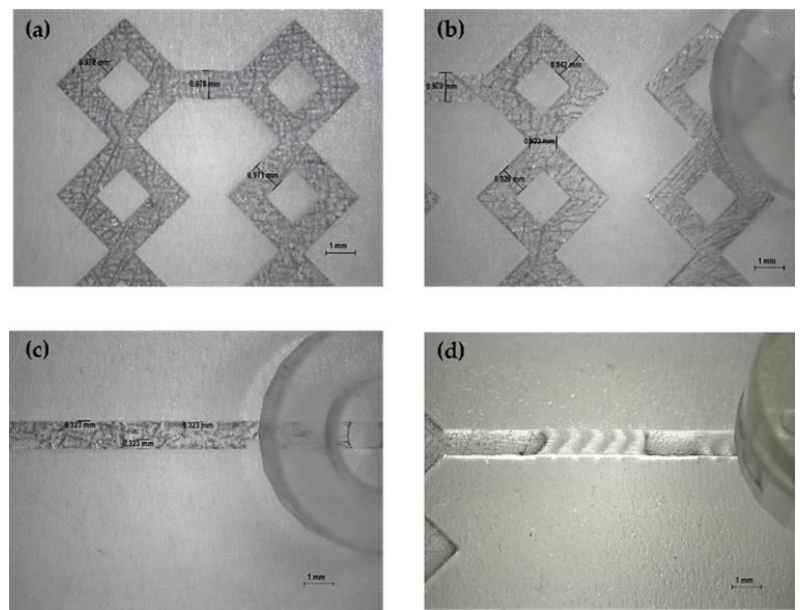
Figure 9. Optical microscope images of diamond-shaped devices produced by Sommonte et al. [118]: ( a , b ) images of the circumvolved internal geometry; ( c ) image of the main channel with wedges inside; and ( d ) image of the main channel with modified herringbone structure inside.